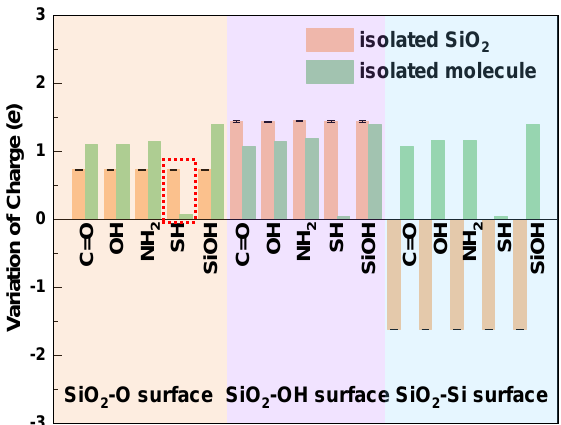
Figure 4. Bader charge analysis on atoms at the isolated SiO 2 surface and the molecule. To gain insight into the nature of contact electrification between molecules and differ- ent SiO 2 surfaces, we calculate the total density of states (TDOS) of these contact systems. Figure 5 shows that the contact between the molecule and SiO 2 substrate causes the states to shift toward the lower energy levels after contact, indicating the stabilization of contact systems. For the molecule/SiO 2 -O and molecule/SiO 2 -Si contact systems, the contribution of molecular contact and charge transfer to electronic orbit can change the minimum of the conduction band of contact systems, which narrows the bandgap of the contact system. Similarly, for the molecule/SiO 2 -OH contact systems, the impurity state induced by the molecule is located below the conduction band, which causes the band gap of the contact system to become narrower after contact. To further explore the direction of charge transfer and contact electrification mechanism of molecule/SiO 2 contact systems, the high-energy states originated by the TDOS of the isolated SiO 2 substrate and the molecule are consid- ered. The high-energy state electrons above the Fermi level influence the charge transfer and the difference in the high-energy state electrons (first peak of the density of states energy) of isolated surfaces can be used to further confirm the direction of charge